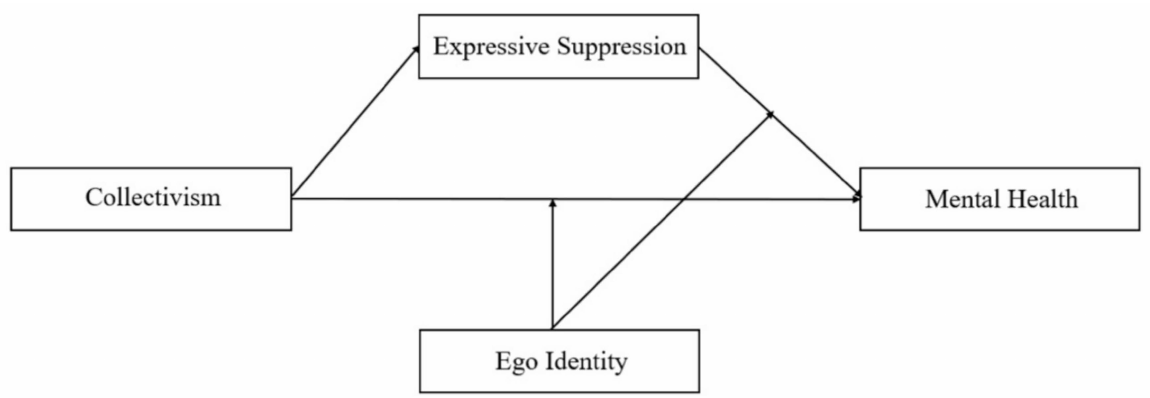
Figure 1. Schematic of moderated mediation